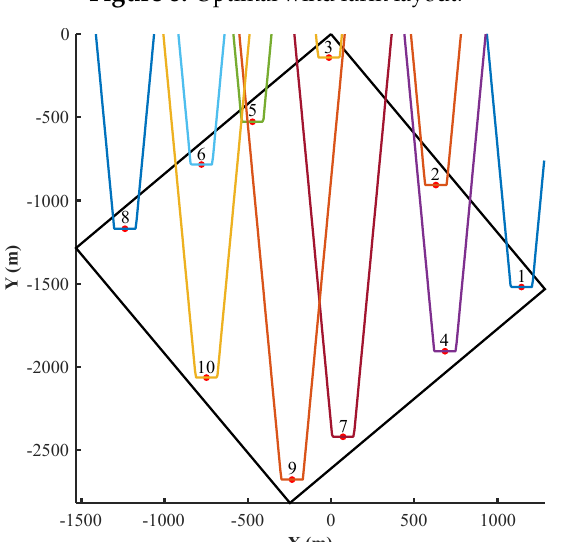
Figure 8. Optimal wind farm layout.